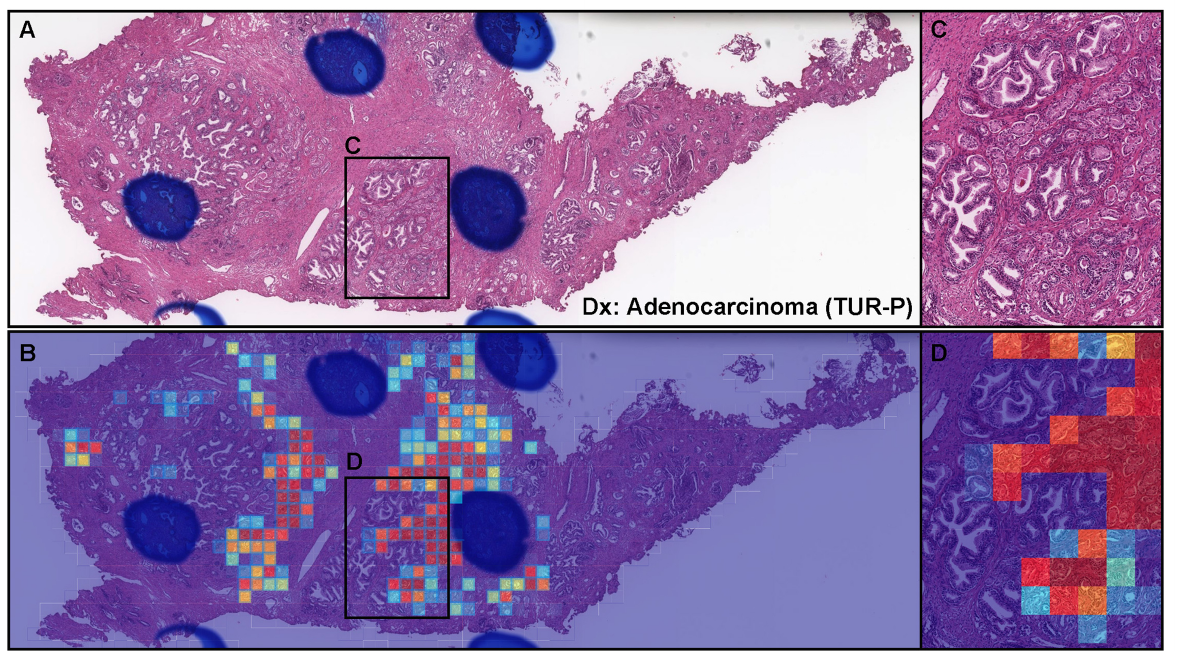
Figure 6. Representative true positive prostate adenocarcinoma from the transurethral resection of the prostate (TUR-P) test sets. In the TUR-P specimen ( A ), there are adenocarcinoma cell infiltration foci ( C ) based on the histopathological report. The heat map image ( B ) shows the true positive prediction of adenocarcinoma cells ( D ) using transfer learning from the colon poorly differentiated adenocarcinoma model (TL-colon poorly ADC-2 (20 × , 512)). The heat map uses the jet color map where blue indicates low probability and red indicates high